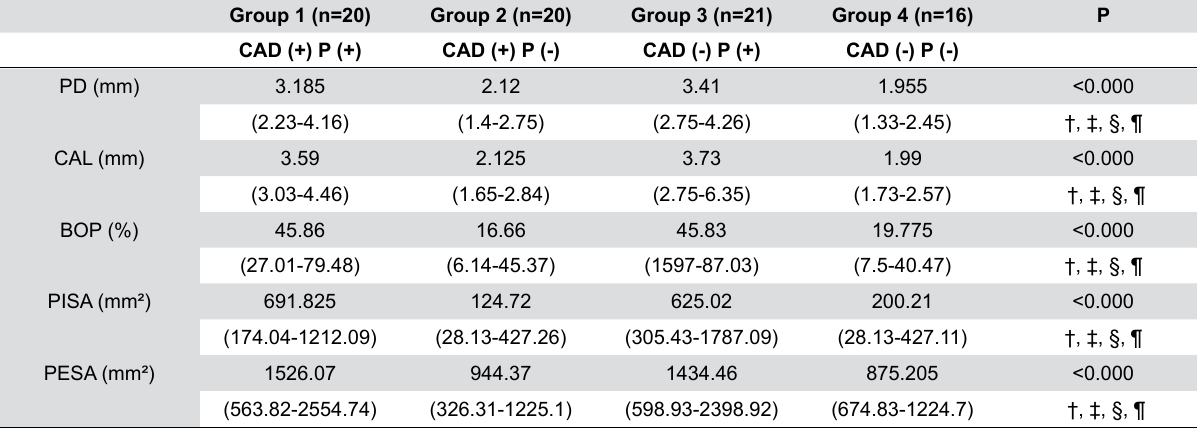
Table 2- Periodontal parameters, PISA and PESA values [median (minimum-maximum)]